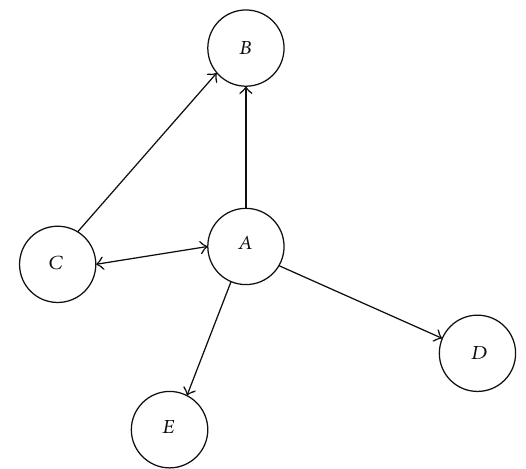
Figure 1: Network for Twitter-like social networks.